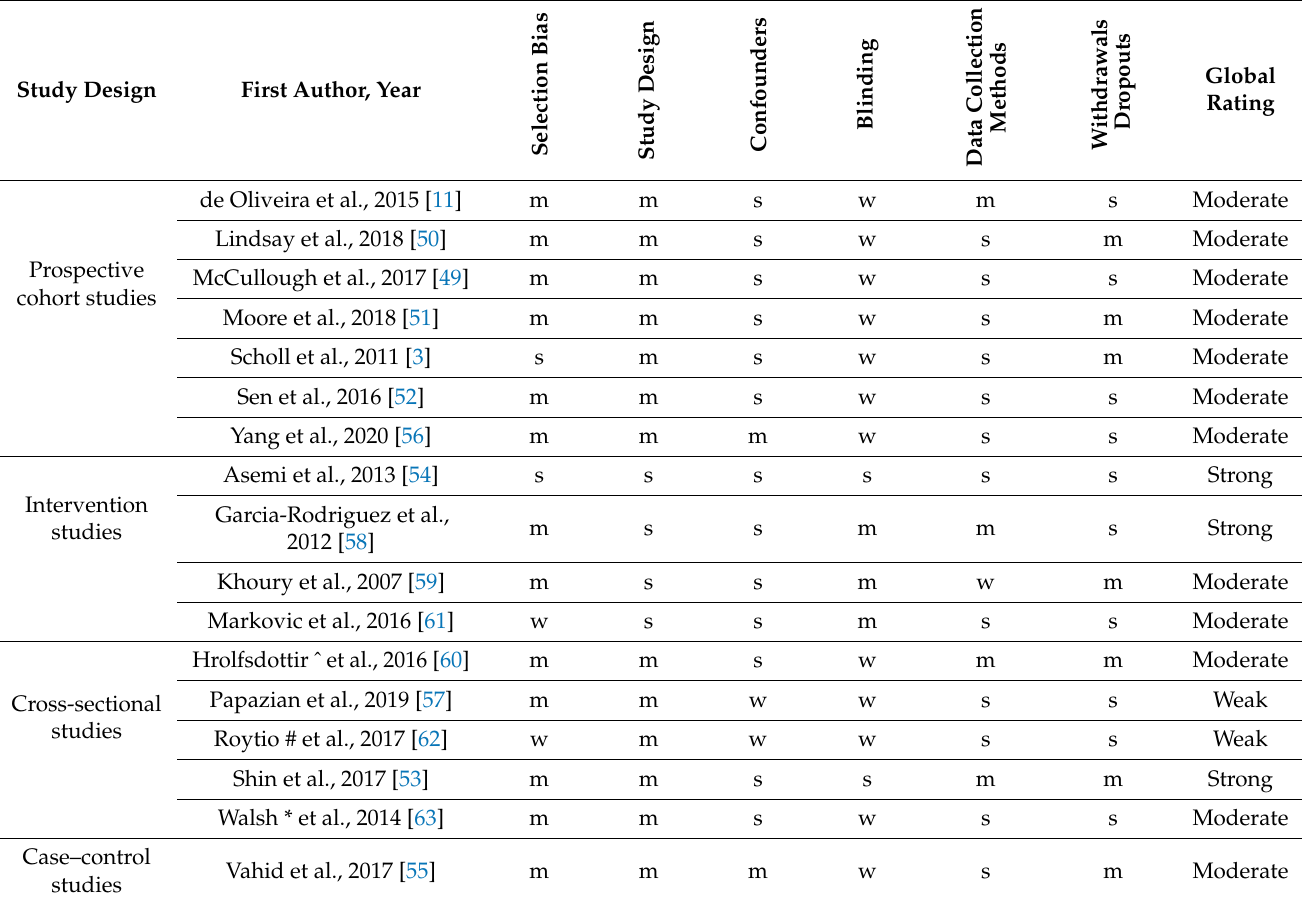
Table 2. Quality of the included studies assessed by the quality assessment tool for quantitative studies.